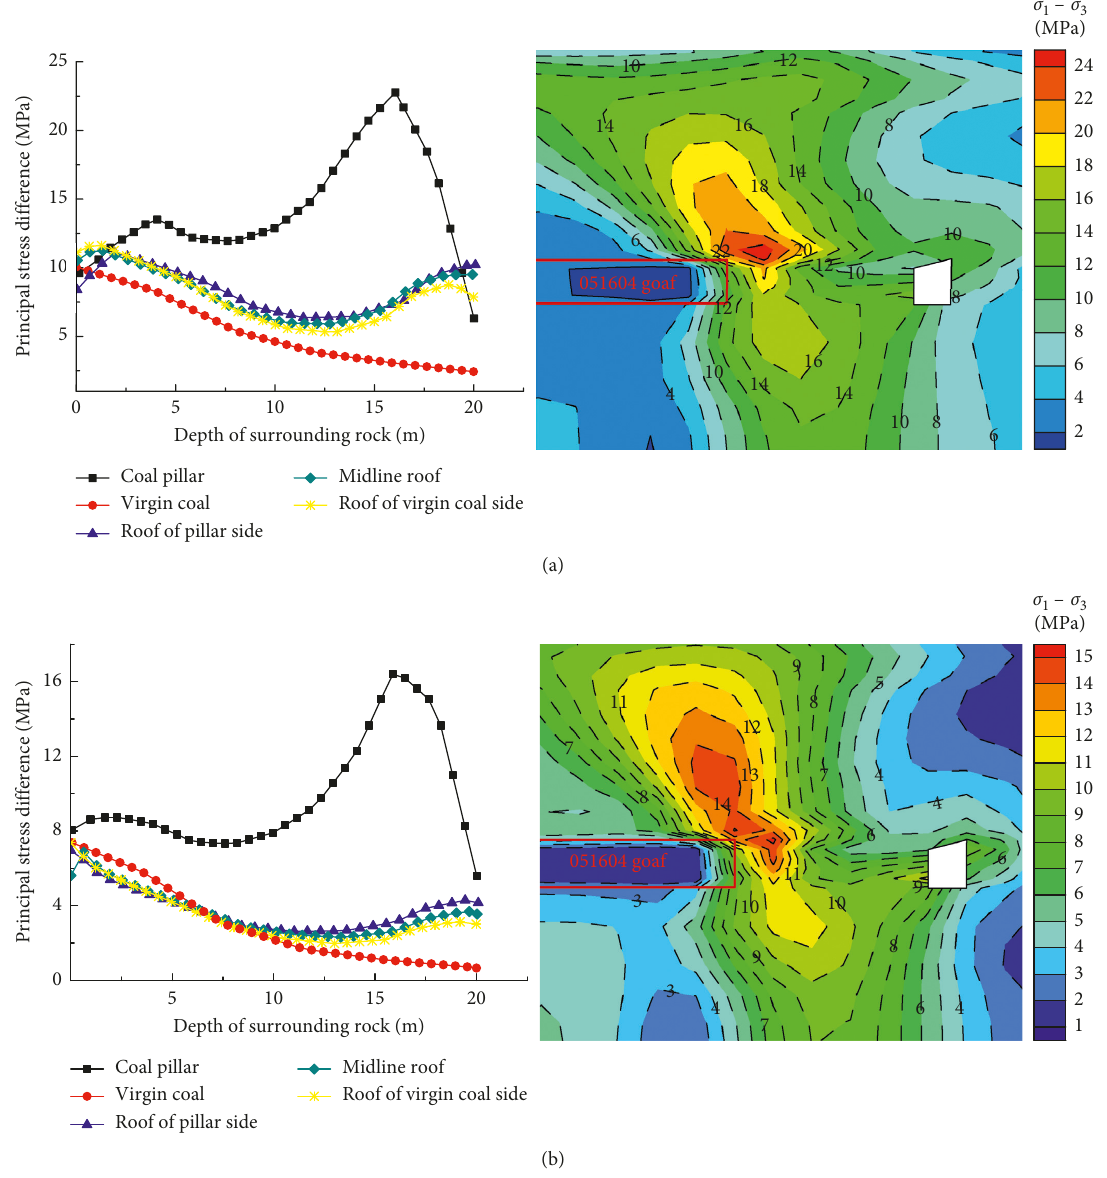
Figure 9: Principal stress difference distribution between single and double layer mining. (a) #15 coal seam in exploited conditions. (b) #15 coal seam in unexploited